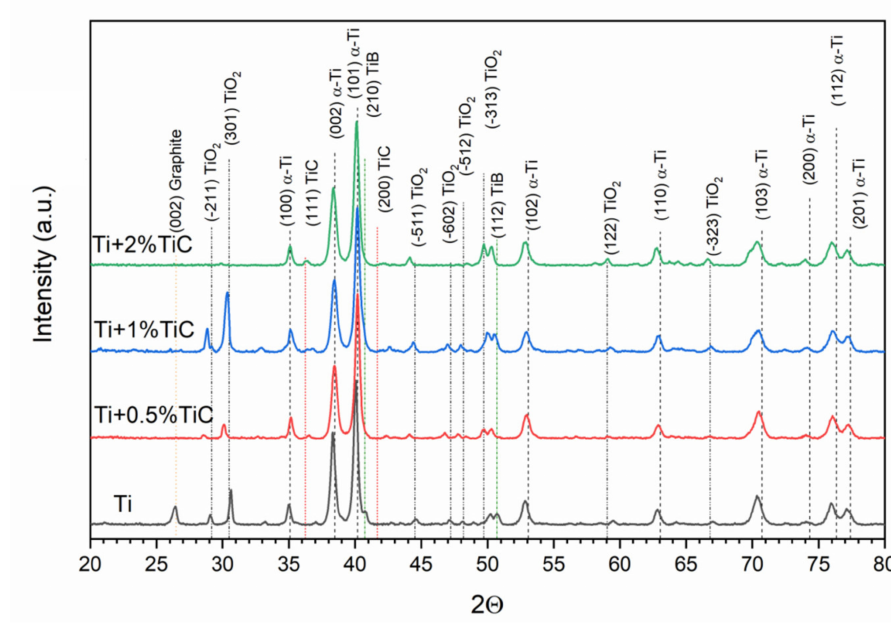
Figure 11. Phase composition of obtained titanium composites, XRD.